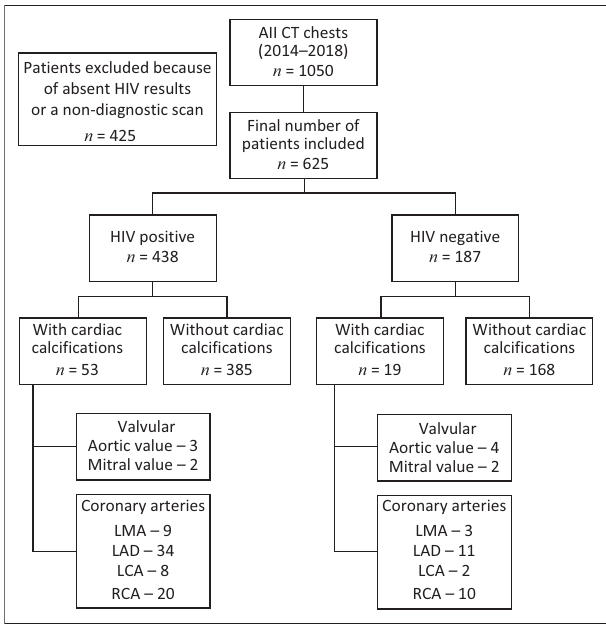
FIGURE 3: Diagrammatic representation of the results.